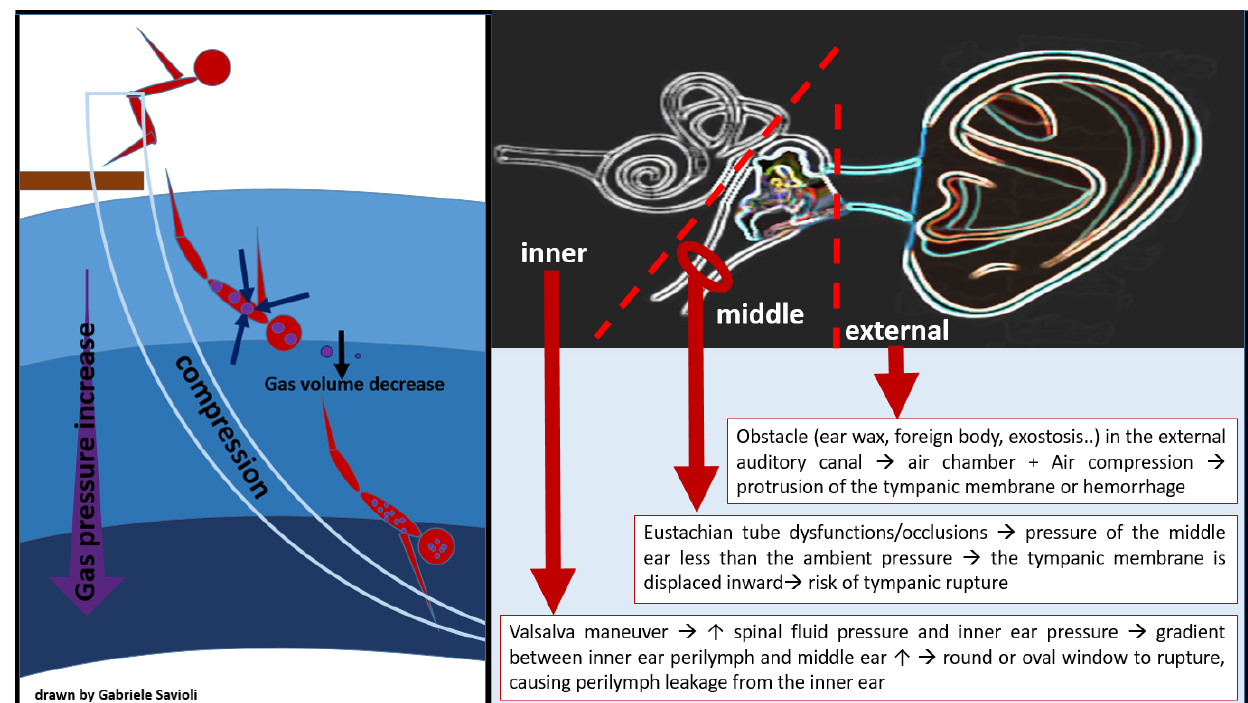
Figure 5. Barotitis: external, middle, and inner.